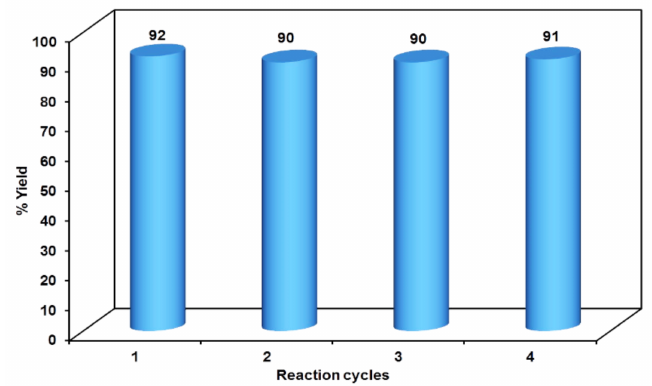
Figure 4. Reusability potency of